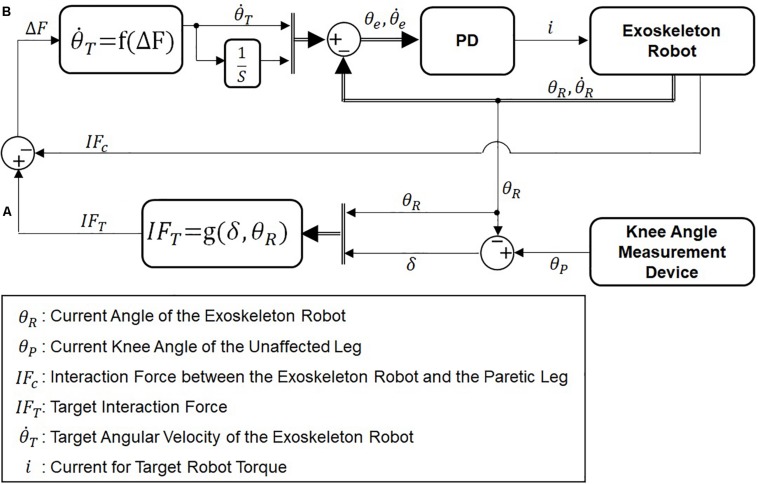
Block diagram of admittance control. (A) Calculation of the desired interaction force and (B) calculation of the desired angular velocity of ATO.